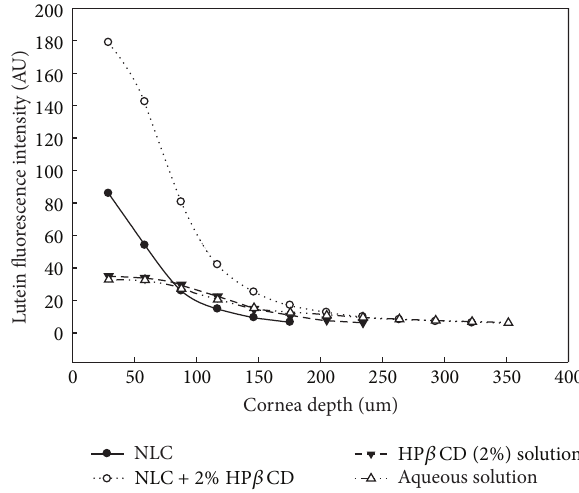
Figure 5: Lutein distribution in porcine cornea after 24 h treatment observed by using confocal laser scanning microscopy. Lutein fluorescence emitted at 515nm was recorded when excited at a wavelength of 488 nm by means of an argon laser. The sample was scanned from the tissue surface (0 𝜇 m) to a depth of 352 𝜇 m at a 29.3 𝜇 m